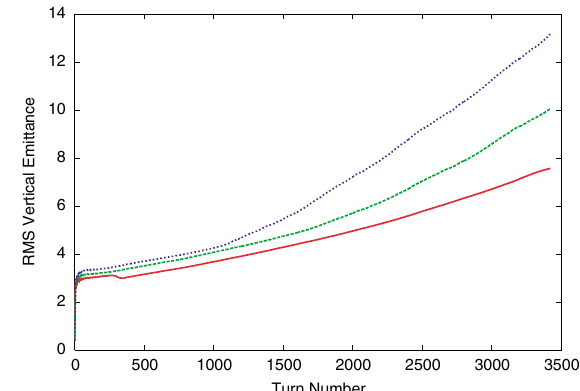
(cid:5) 2 : 19 y (cid:5) 2 : 09 y